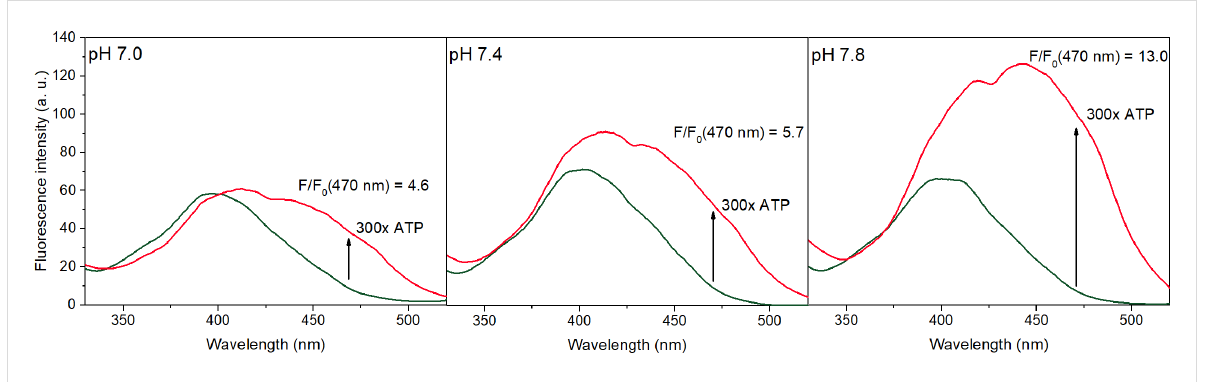
Figure 4: Excitation spectra of UHF (dark green line, 1 μ M) and UHF + 300 equiv ATP (red line), measured at different pH values. The fluorescence enhancement values at 470 nm are also noted. The spectra were detected at 540 nm in 0.02 M HEPES buffer, in the presence of 0.1 mM γ -cyclo- dextrin.